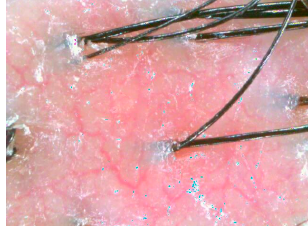
Figure 2. Some pixels are overprocessed and show a different color than the surroundings when α has a value higher than 0.5. Table 6. Examples of PCA Augmentation. Red Image Yellow Image White image Green Image Blue Image 𝐼 (cid:3051)(cid:3052) (input) 𝐼 (cid:3043)(cid:3030)(cid:3028) (result)